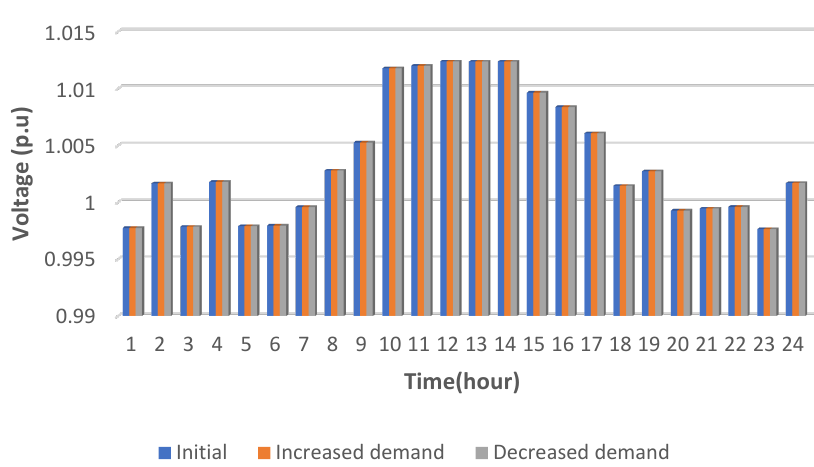
Figure 18. The voltage of the VPP in summer.